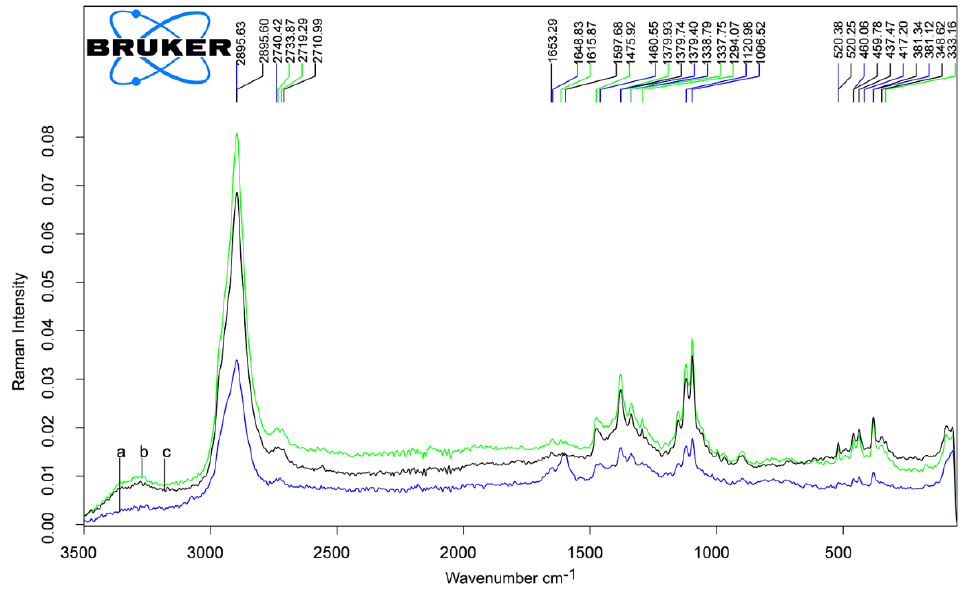
Figure 9. FT-Raman spectra for paper medium: ( a ) S1, ( b ) S2, ( c ) S3.